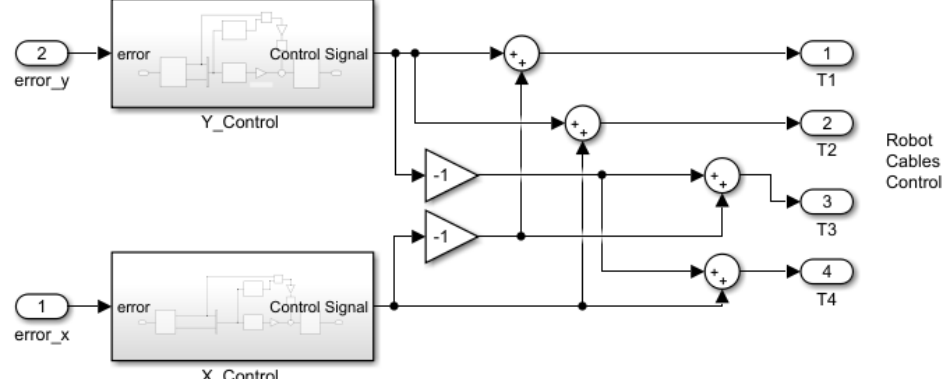
Figure 3. Control structure for the positioning of a planar CDPR.